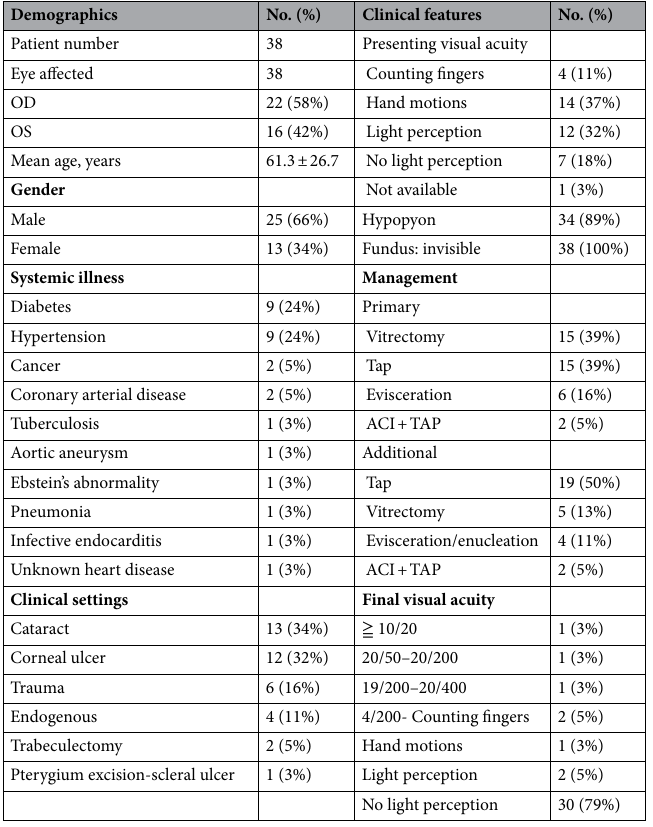
Table 1. Demographics, clinical settings and features, managements, and outcomes of patients with Streptococcus pneumoniae endophthalmitis. ACI anterior chamber irrigation; TAP tap and